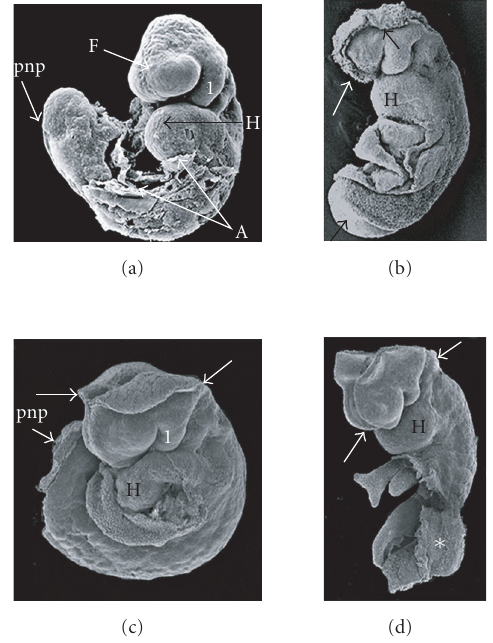
Figure 6: E ff ects of Bmp shRNA . (a) Scanning electron microscopy (SEM) view of a control embryo illustrating completed neural tube closure in the forebrain (F) region; the posterior neuropore (pnp) has not yet been closed. (b) Bmp4 shRNA-exposed embryo with widely open anterior neural folds (arrows) and posterior neuropore (lower black arrow). (c) SEM view of a Bmp 7 shRNA-exposed em- bryo. Both the midbrain (arrows) and the posterior neuropore (pnp arrow) are widely open, but the body axis defects characteristic of Bmp4 shRNA and Bmp4 + 7 shRNA embryos were not present. (d) Ventrolateral SEM view of a compound Bmp4 + Bmp7 shRNA em- bryo. The cephalic neural folds are unfused (arrows) and the poste- rior region is rudimentary ( ∗ ). 1: first branchial arch, A: amnion, F: forebrain, H: heart, pnp: posterior neuropore.